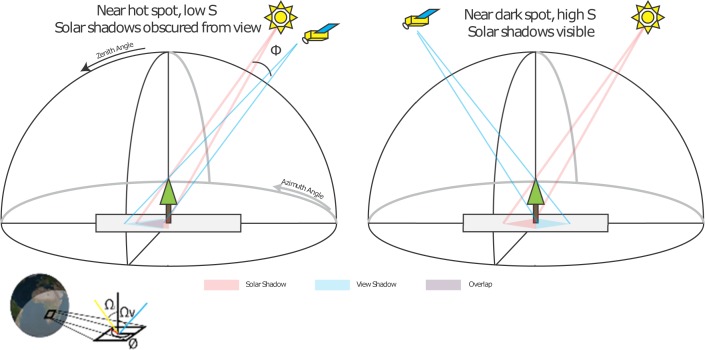
Perspective view diagram showing the geometry for a tree viewed at close to the hot spot (left) and close to the dark spot (right).Φ is phase angle, Ωv is the view zenith angle, Ωi is the sun zenith angle Ωi, and Ø is the relative azimuth angle.